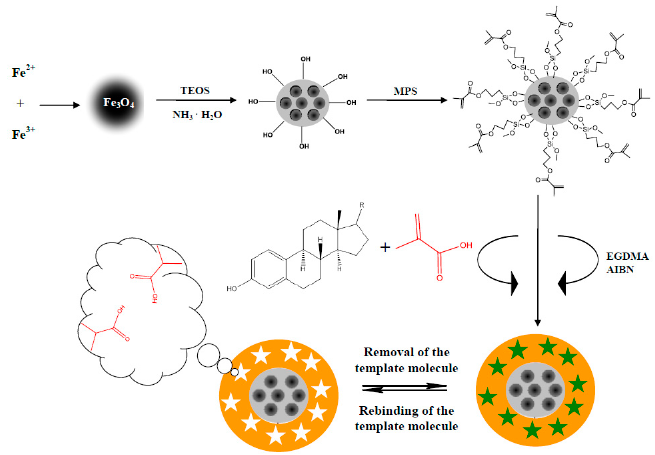
Figure 2. General steps for the preparation of estrogens (R = O or OH) magnetic molecularly imprinted polymers.